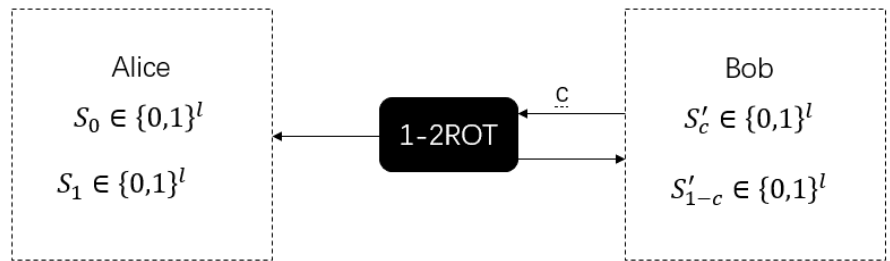
Figure 4. The ideal functionality of 1-2 random oblivious transfer (ROT). Bob has input c , Alice gets S 0 , S 1 , and Bob gets outputs S (cid:48) c , S (cid:48) with S c = S (cid:48) c and S 1 − c (cid:54) = S (cid:48) 1 − c 1 − c